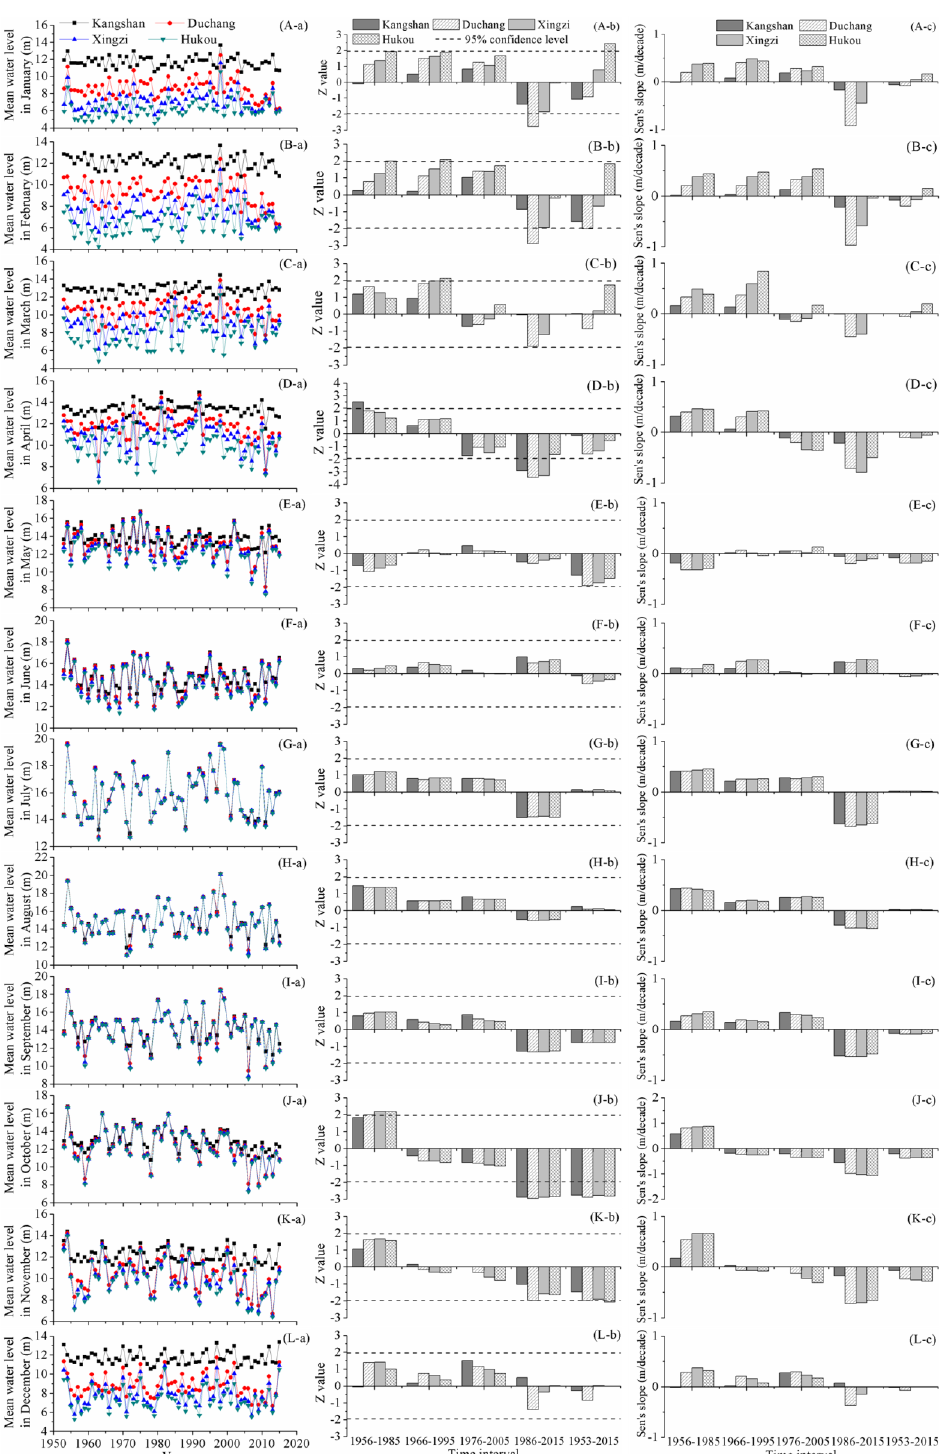
Figure 2. Change characteristics of monthly mean water level in Poyang Lake: (i) the sub-figures from the top to the bottom rows that are labeled (A–L) display monthly mean water level changes in January to December; and (ii) the sub-figures from the left to the right columns that are labeled (a–c) display annual values, Z values, and Sen’s slopes, respectively.